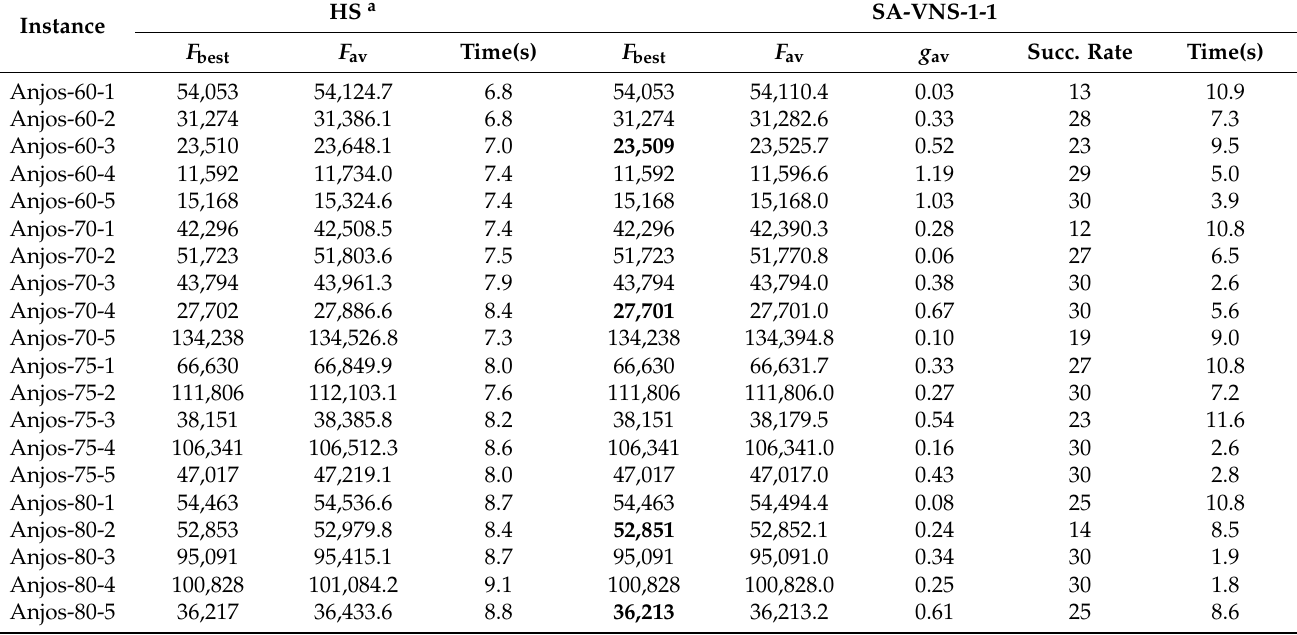
Table 6. Performance comparison for the Anjos instances of the tool indexing problem.